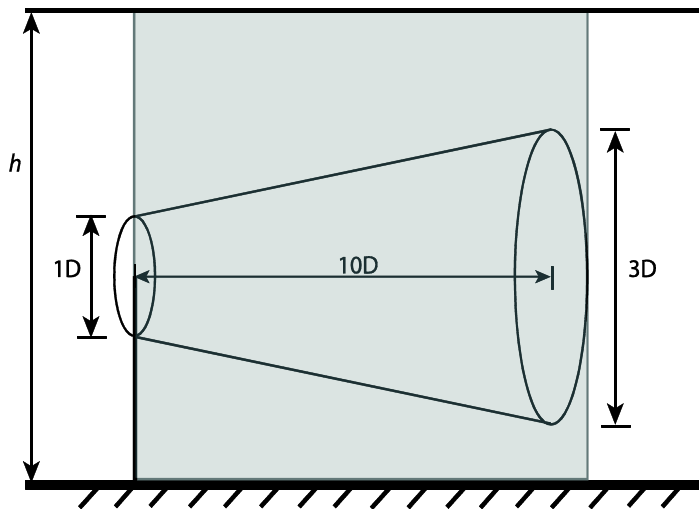
Figure 9. Cone-like volume of air encompassed by turbine wake.